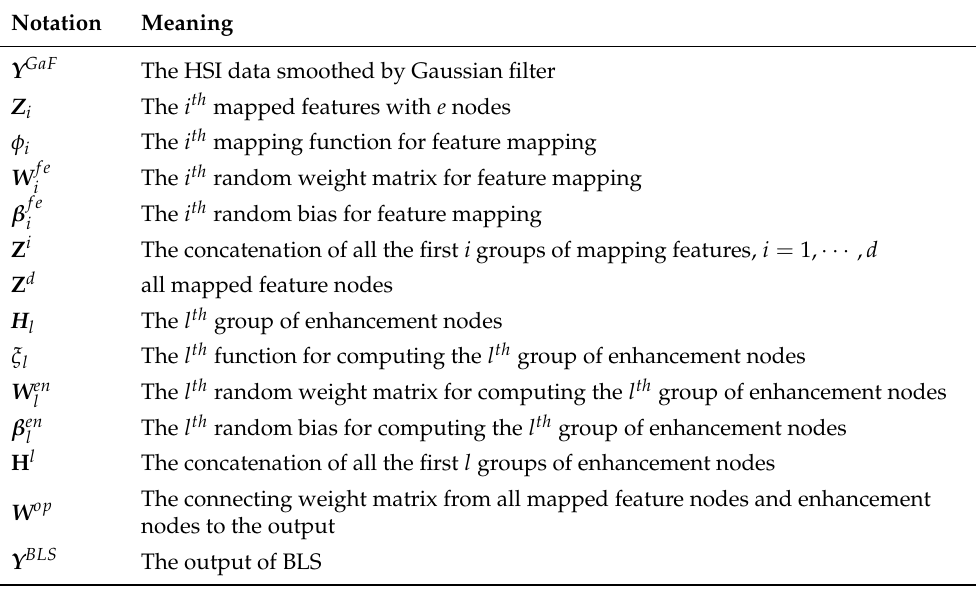
Table 1. The meaning of notations in BLS classification